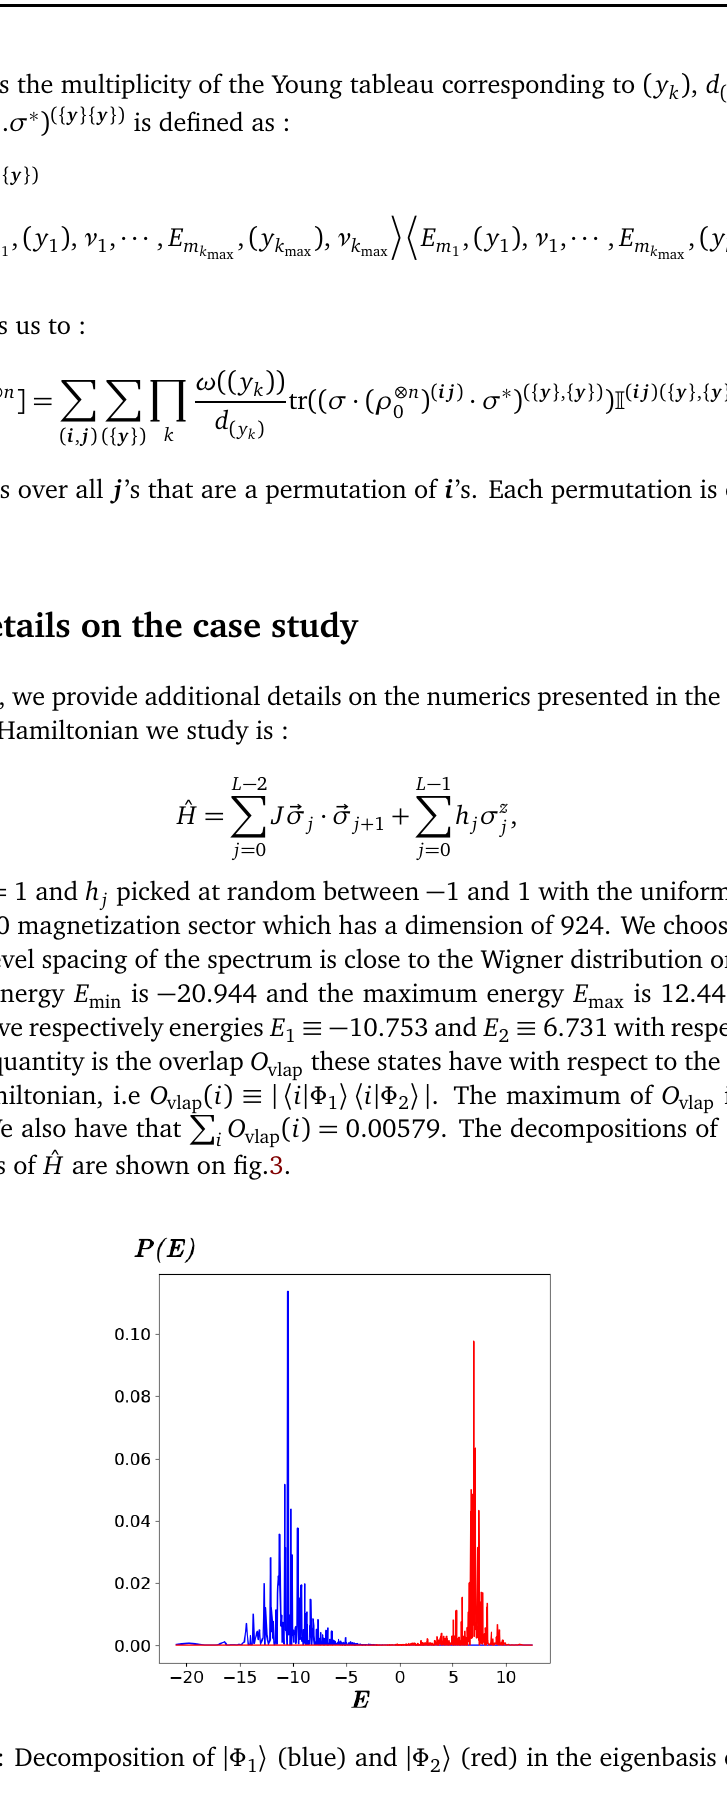
Figure 3: Decomposition of | Φ